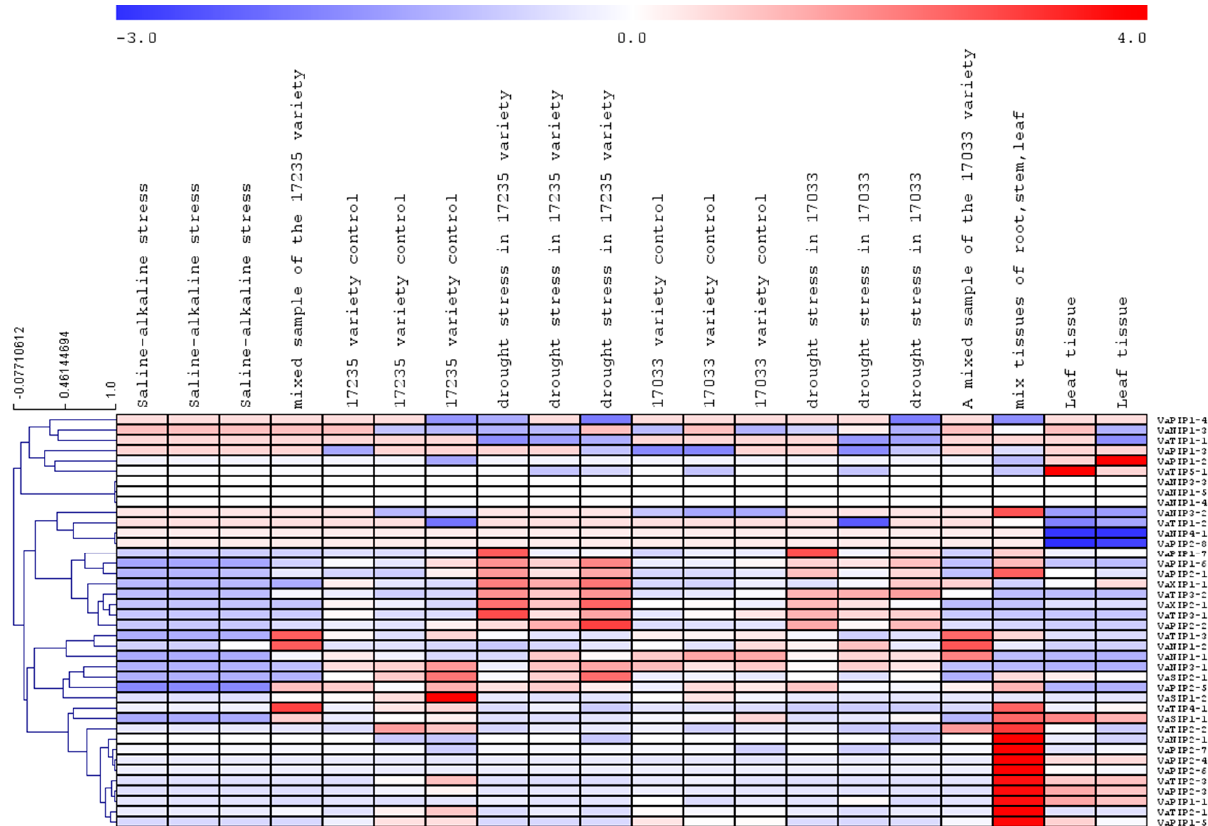
Figure 6. Heatmap and hierarchical clustering of the expression values relative to V. angularis aquaporins . The heatmap expression of all the aquaporins in different conditions is based on the RPKM values. The blue color represents low-expressed genes and the red color represents highly expressed genes.